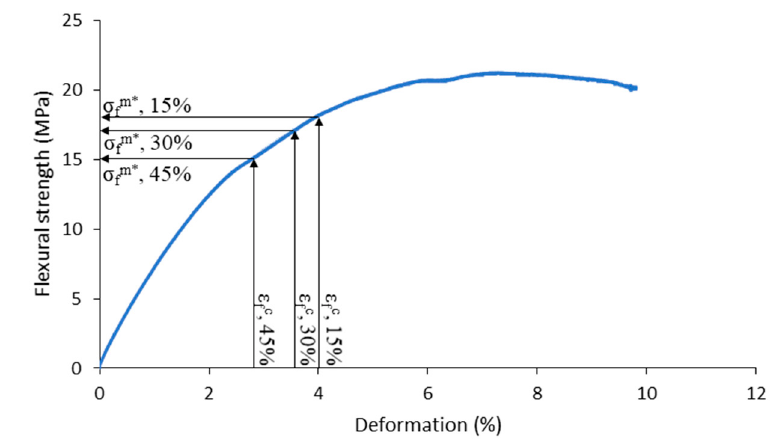
Figure 5. Flexural stress-strain curve of BioPE. Evaluation of the matrix contribution to the flexural strength of the composite .